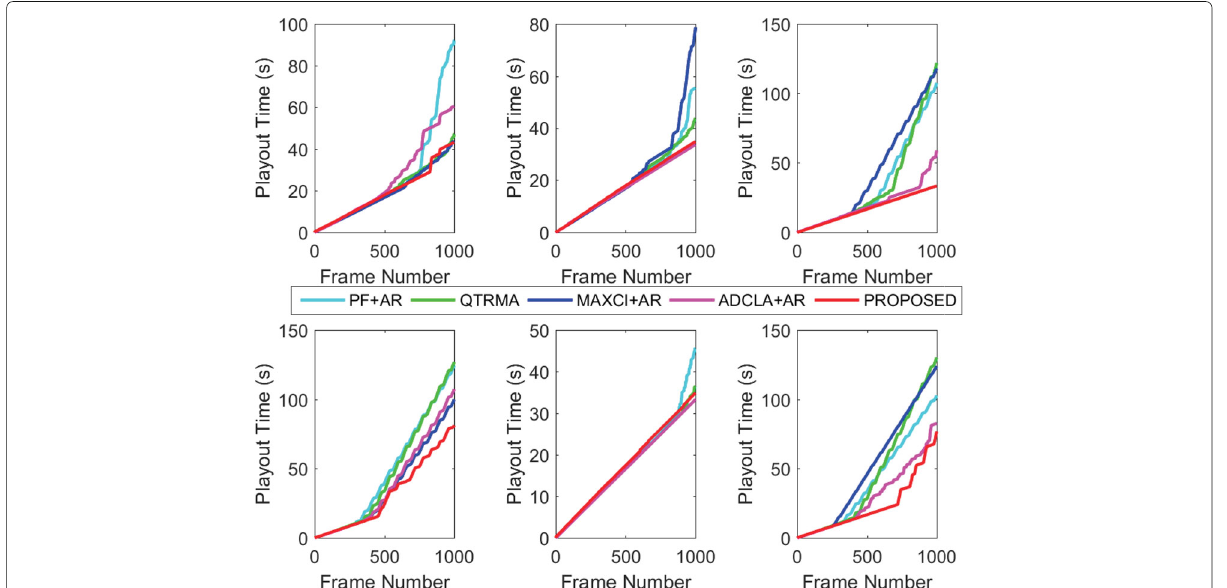
Fig. 5 Playback time of each frame of each client for different algorithms